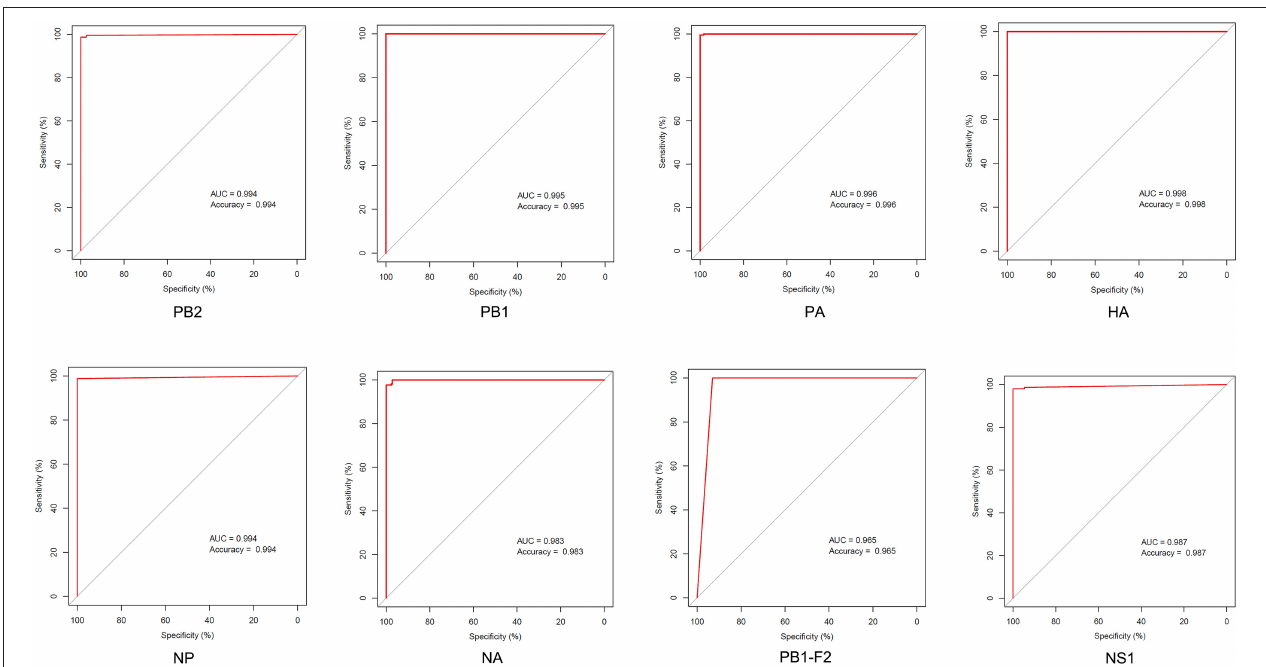
FIGURE 7 | ROC curve of host identification by the avian–canine signatures of different